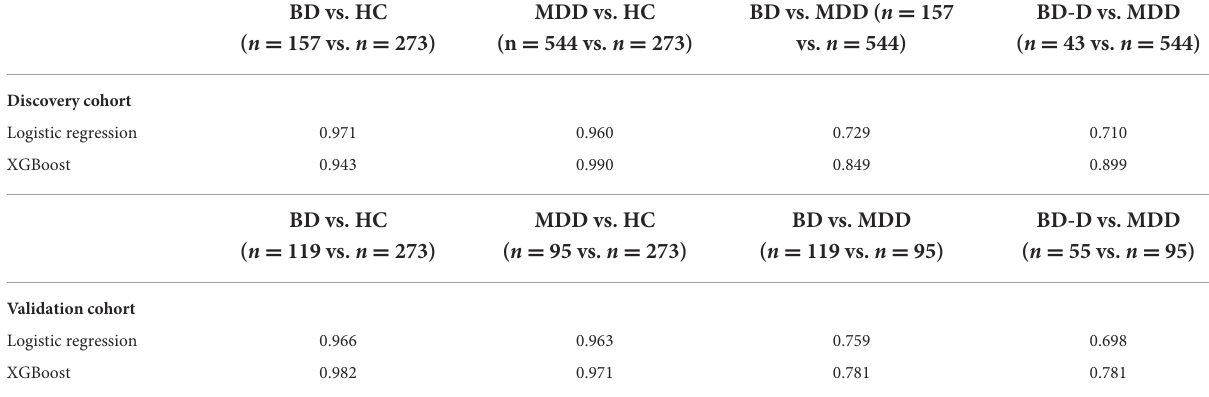
TABLE 2 AUC of two prediction models.